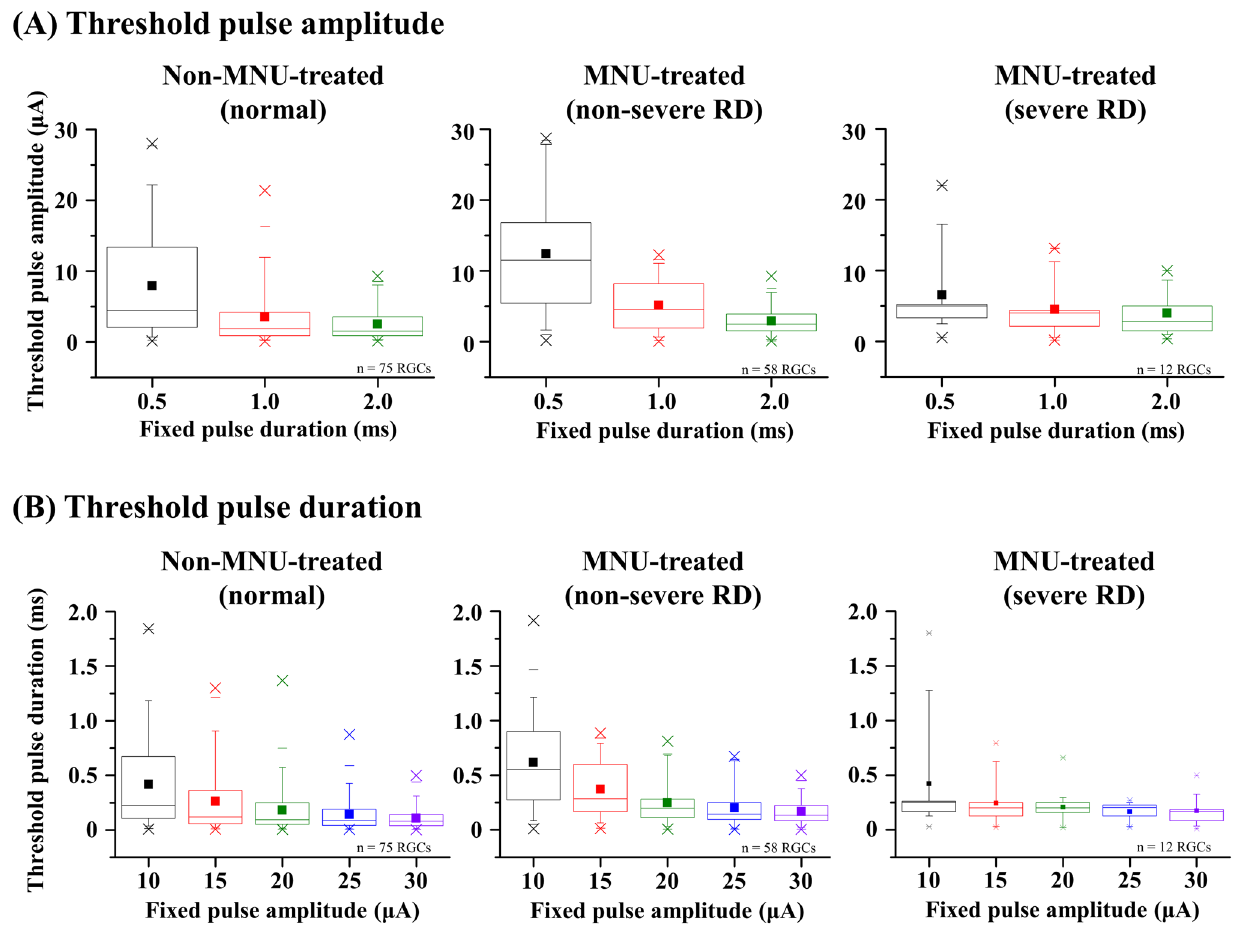
Figure 5. Comparison of threshold pulse amplitude and threshold pulse duration in non-MNU-treated and MNU-treated groups. Values of threshold ( A ) pulse amplitude and ( B ) pulse duration calculated from individual RGCs. The boxes show the range from first to third quartiles. The bottom whisker span from the first quartile box down to 5% and the upper whisker span from the third quartile box up to 95%. The midline of the box represents the median value of thresholds. The filled square symbol represents average value of thresholds. The thin horizontal bars represent 1% and 99%. The minimum and maximum value of threshold are plotted as cross symbols.